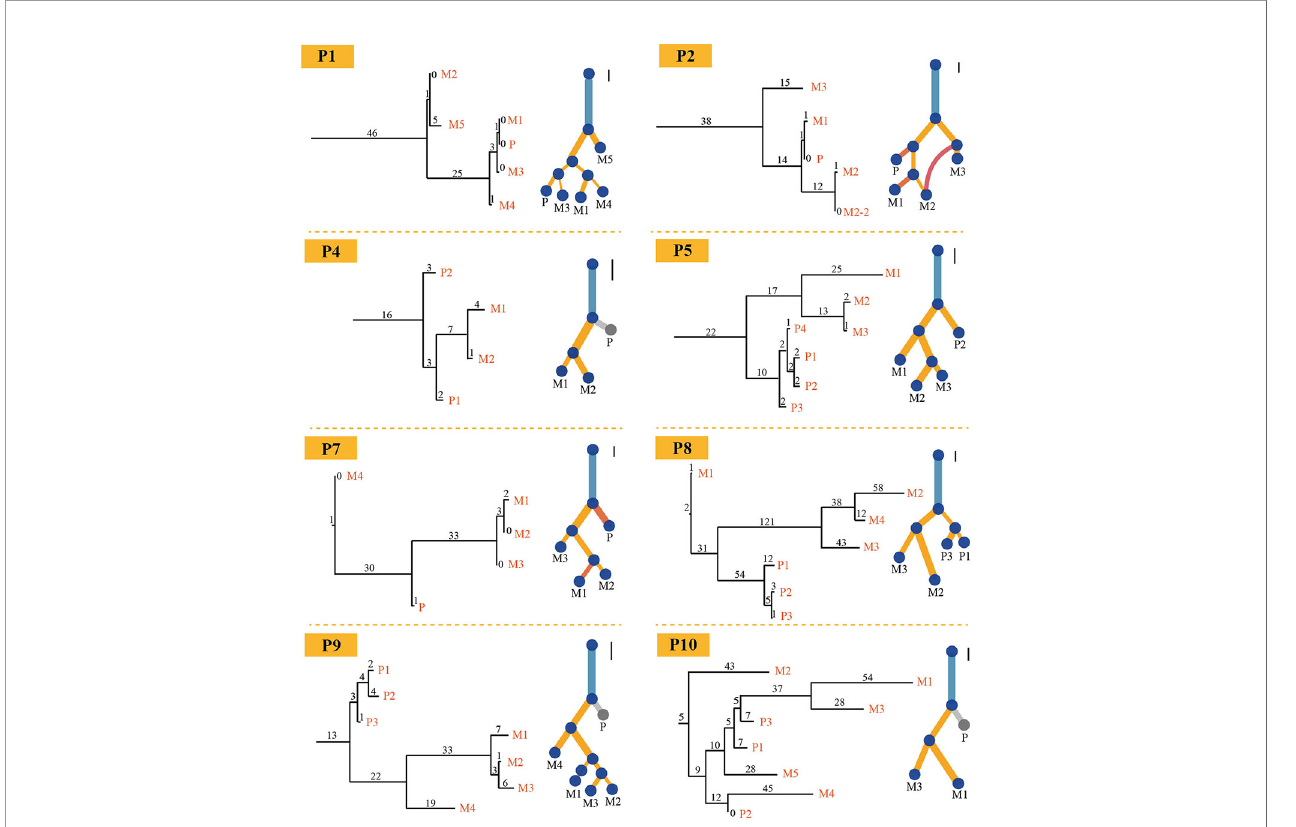
FIGURE 3 | Comparison of trees for eight breast cancer patients. Eight phylogenetic tree structures without annotation information about the driver gene inferred by PTI using all somatic mutations with >=1500X coverage and >=3% VAF (on the left) are compared with the trees (on the right) published in Brown et al. (2017) for each patient on breast cancer data set. As for PTI results, the number of shared mutations is proportional to the length of branch and labeled above each branch. Also, the scale bars on the upper right corner of the results given in original published paper represent 10 SNVs and provide an indication of the original length of the